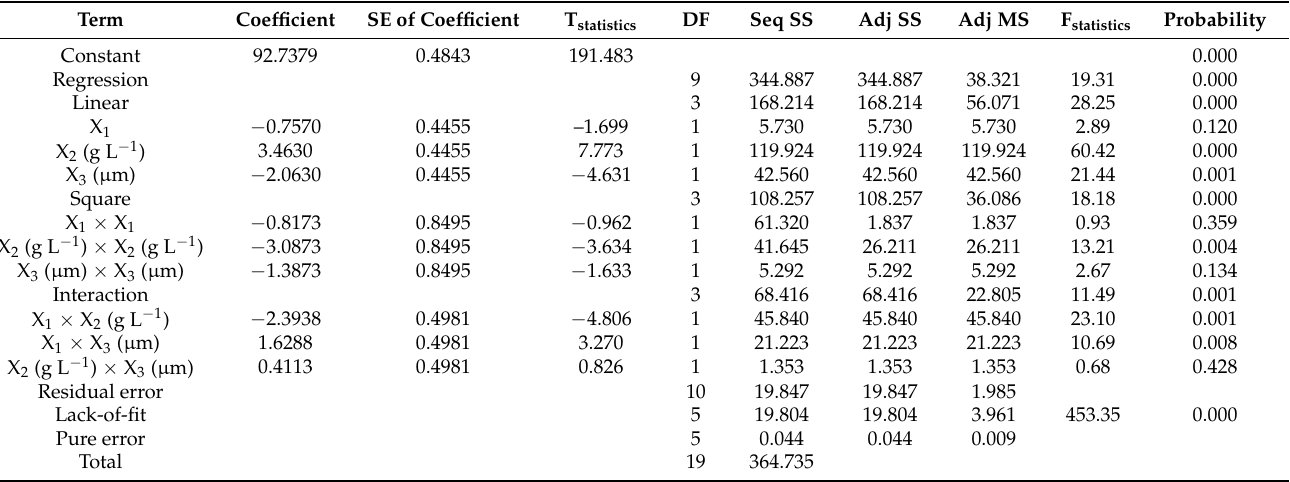
Table 4. Analysis of variance (ANOVA) for decolorization efficiency of RBBR dye using WSBAC adsorbent in 2 3 full factorial central composite